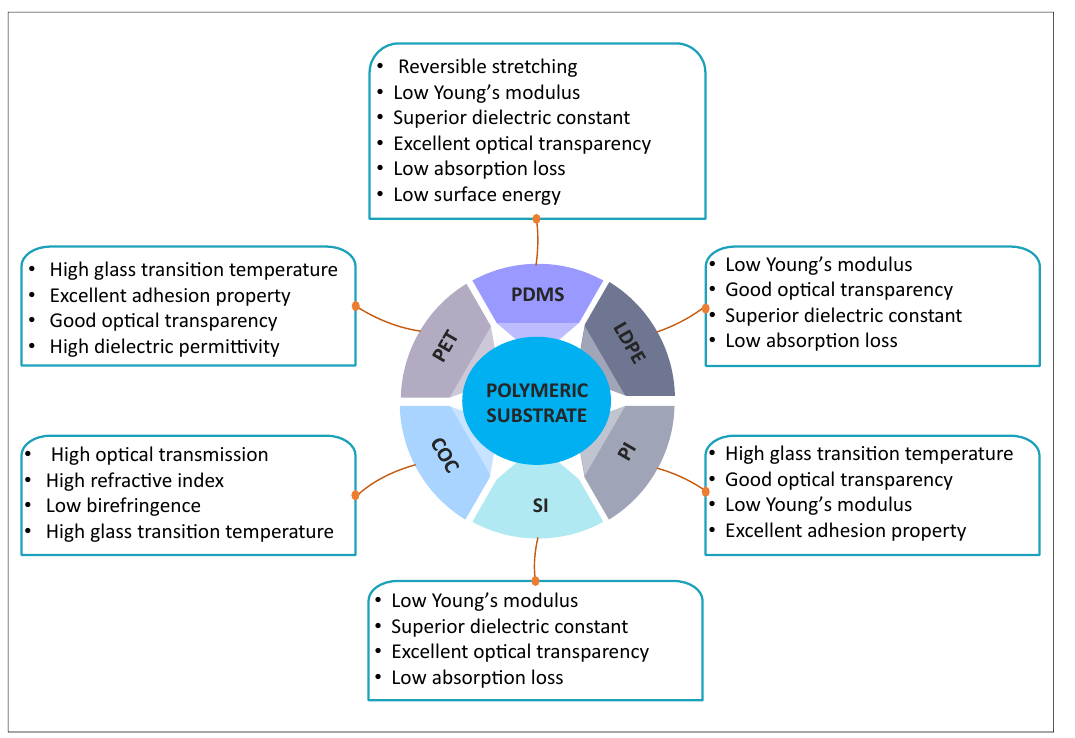
Figure 2. Polymers for mechanically tunable metasurfaces. PDMS: PDMS possesses excellent re- versible stretching that makes it viable for mechanical tuning of metamaterial properties. The elas- tomeric properties of PDMS render it a suitable conformable substrate for non-planar surfaces. Its low surface energy enables the integration and transfer of transparent oxides. PDMS allows imprint- ing, which enables mass production of flexible and tunable metamaterials. LDPE: LDPE has a low elastic modulus, enabling easy stretching. The low absorption loss ensures maximum transmission of electromagnetic waves. The optical transparency of LDPE makes it suitable for broadband met- amaterial applications. PI: PI possesses excellent adhesive properties that enable strong adhesion to meta-atoms. Its resistance to corrosive etchants makes it suitable for micro-nanofabrication. The glass transition temperature of PI enables direct deposition of metals. PET: PET exhibits strong ad- hesion to metals and photoresists, rendering it viable for micro-nanofabrication. PET exhibits optical and electromagnetic properties comparable to that of PDMS. SI: SI exhibits low absorption loss comparable to PDMS. Its high transparency makes it suitable for broadband metamaterials in the visible region. COC: COC has excellent electromagnetic properties for broadband tunable met- amaterials. It possesses a high glass transition temperature that allows direct micro-nanofabrication. Table 1. Typical properties of polymeric – deformable substrates for mechanically tunable metasur- faces.